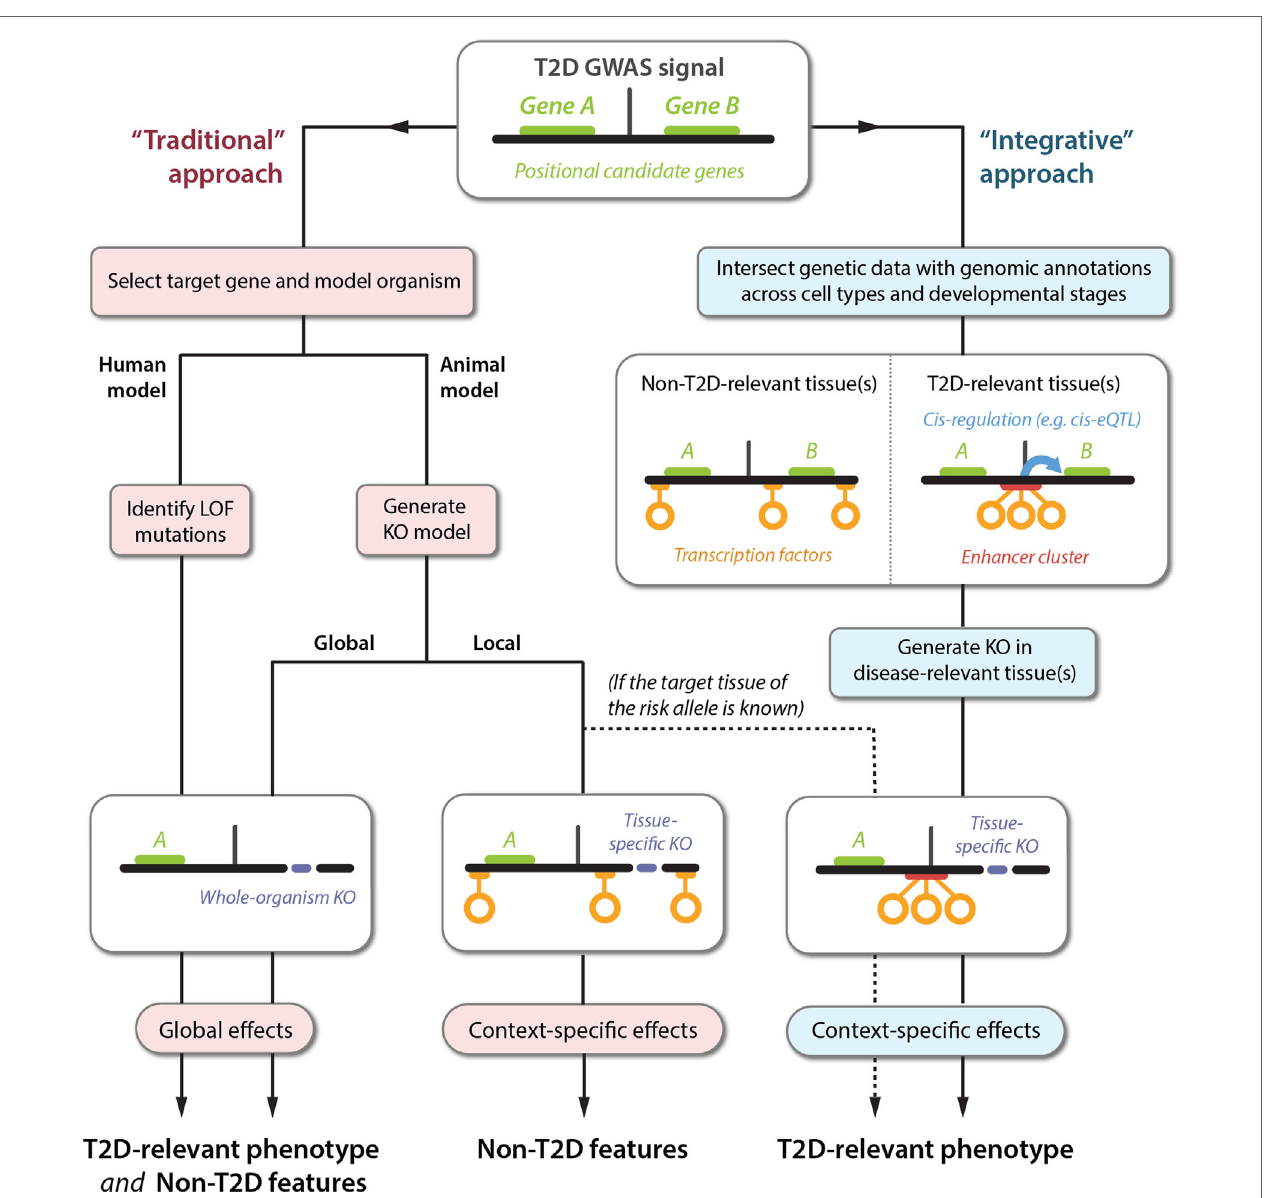
FiGURE 1 | Translating GWAS signals into disease mechanisms using traditional and integrative approaches . The top panel shows a schematic representation of a GWAS locus with a non-coding association signal for T2D risk located near two genes, A and B . The left-hand side represents the traditional approach followed for elucidating the causal mechanisms leading to a T2D phenotype. This approach can produce a range of phenotypes that are difficult to translate into causal GWAS mechanisms, because the selected genes are often knocked out globally (bottom left panel), or in a tissue-specific context that is irrelevant to understanding the effects of the T2D susceptibility phenotype (bottom center panel). Sequencing approaches can also be used to identify gain-of- function mutations (not shown), which are subject to the same limitations. The right-hand side outlines an alternative approach using integration of emerging datasets to produce directed hypotheses. For optimal resolution, several types of genetic and genomic datasets can be integrated, including TF binding, enhancer regions (defined based on chromatin state), and cis-regulatory relationships (e.g., identified by cis-eQTL or chromatin-conformation capture studies). In this example, the GWAS signal is observed to disrupt an enhancer cluster with cis-regulatory activity toward gene B . Importantly, the disruption exclusively affects enhancer activity in disease-relevant tissues. This proposes a follow-up experiment for manipulation of gene B in a specific context (bottom right panel), producing a phenotype that is likely to be directly relevant to understanding the molecular basis of T2D